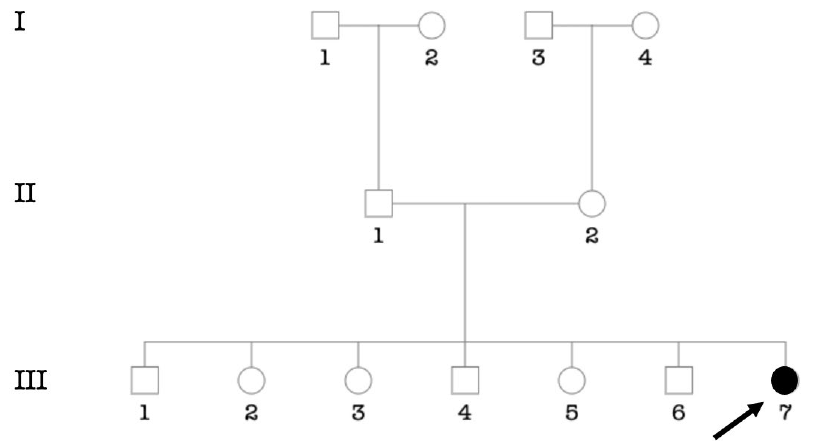
Figure 8. Pedigree of a simplex family with Down’s syndrome. The arrow indicates the